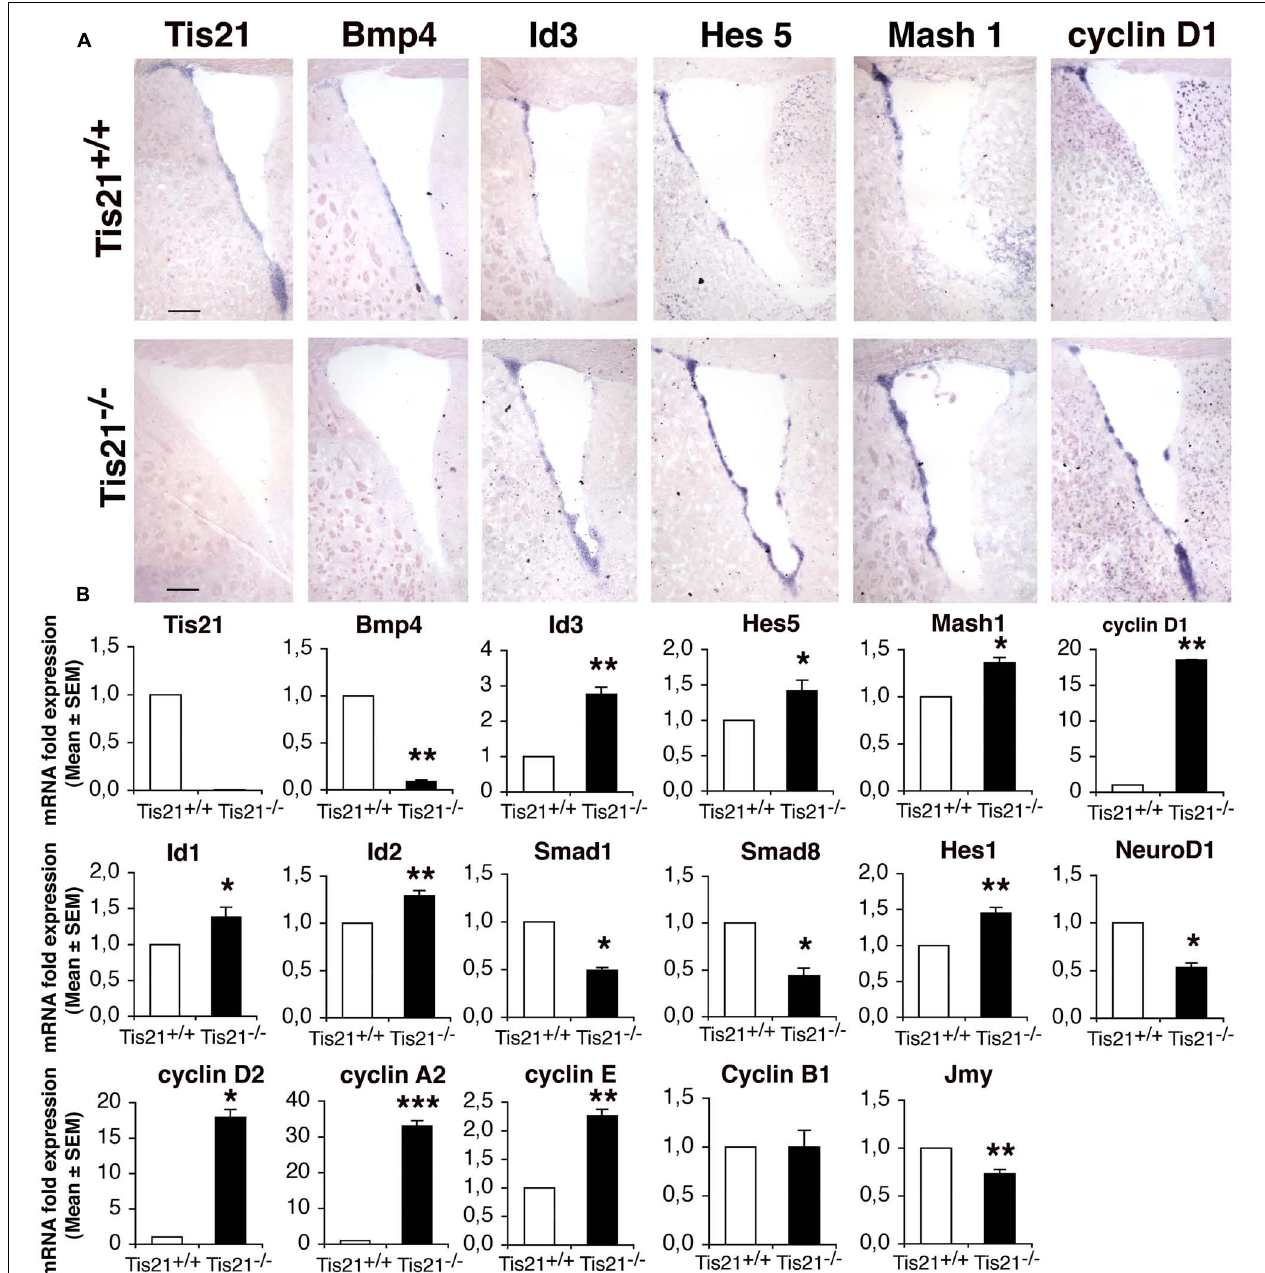
FIGURE 1 | Expression of the BMP, Notch , and cell cycle signaling components in the SVZ and in neurospheres of adult wild-type and Tis21 knockout mice. (A) In situ hybridization in coronal sections of SVZ from P60 Tis21 -null and wild-type mice, of Tis21 , BMP4 , the downstream target Id3, the Notch effector Hes5 , the bHLH gene Mash1 and cyclin D1 . Scale bar 200 μ m. (B) Real time PCR analysis of neurosphere cultures from SVZ neural stem cells of P60 mice; deprivation of Tis21 results in the